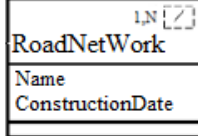
Figure 5. Example of fuzzy collection geometry